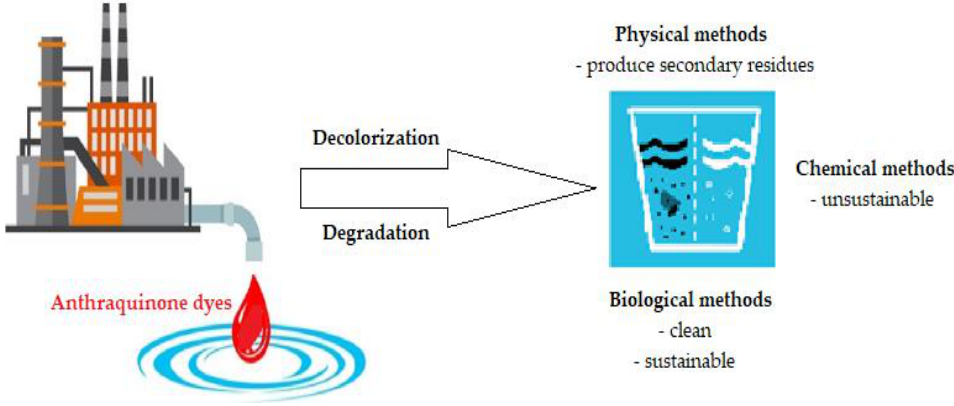
Figure 8. Existing methods of decolorization (modified from [76]).